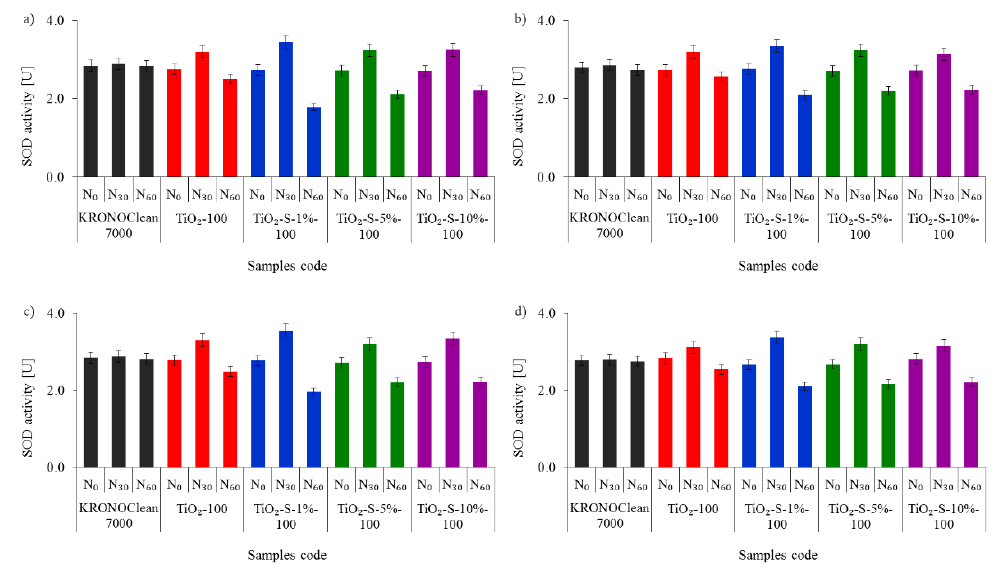
Figure 12. Influence of tested photocatalysts on the activity of bacterial catalase (SOD): ( a ) E. coli under UV-A; ( b ) E. coli under ASL; ( c ) S. epidermidis under UV-A; ( d ) S. epidermidis under ASL.